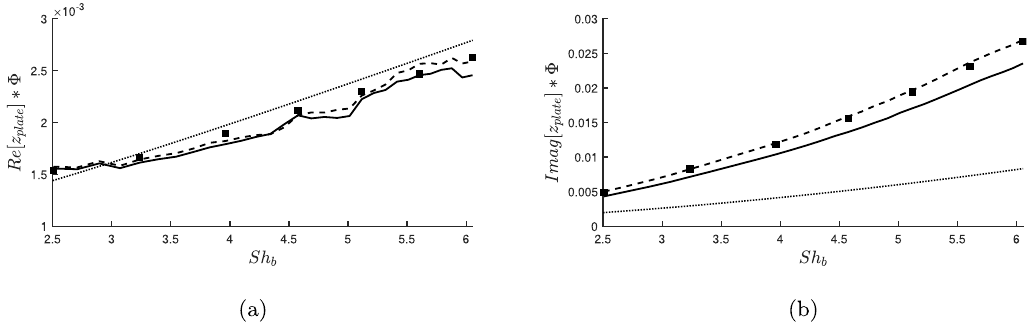
Figure 6. Comparison of the a) slit resistance and b) slit inertance for short ( –– ) and long (- - -) slits as a function of Shear number in linear regime. The numerical model ( & ) and the semi-analytical model for a plate with square sharp edges (. . . .) are shown [20].